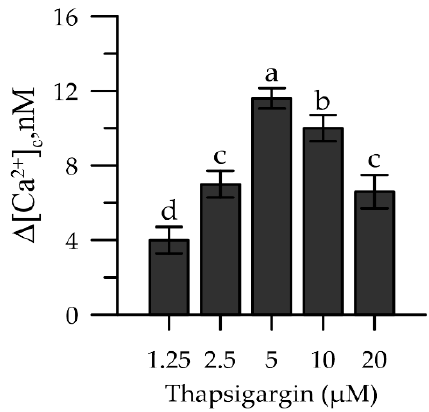
Figure 2. Effect of thapsigargin (1.25–20 μ M) on the cytosolic Ca 2+ of maize pollen. Data are ex- pressed as means ± SEM from five independent tests. Different letters above bars indicate signifi- cant differences at p ≤ 0.05, whereas same letters indicate non-significant differences.